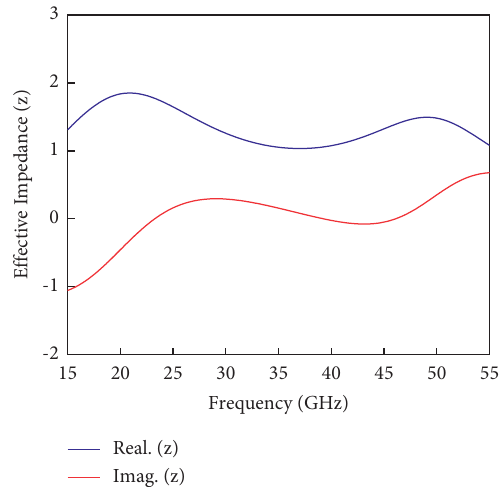
Figure 8: The relative impedance of the proposed